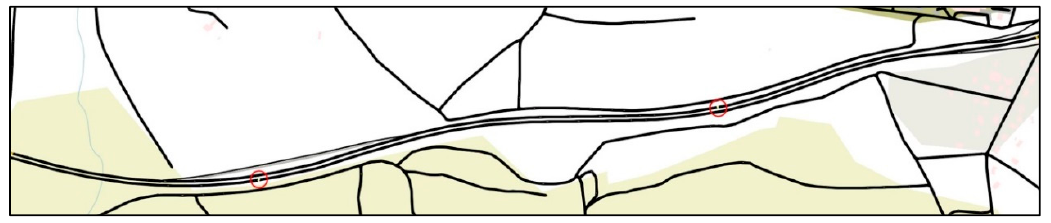
Figure 11. A711 highway of Clermont-Ferrand, France.